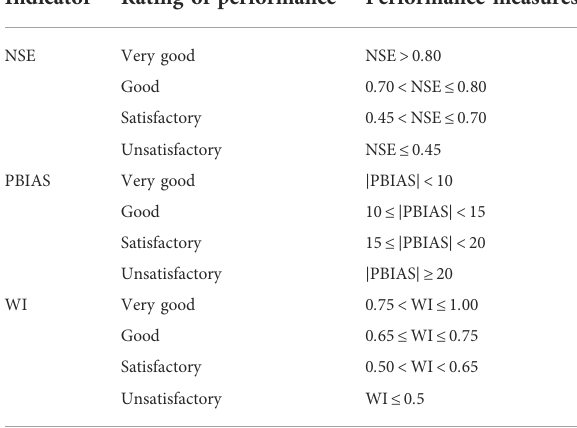
TABLE 3 Evaluation indicators and associated rating of performance. Indicator Rating of